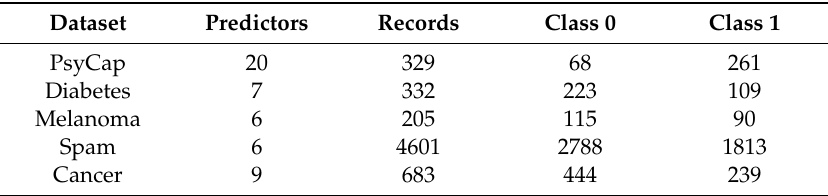
Table 2. Properties of the experimental